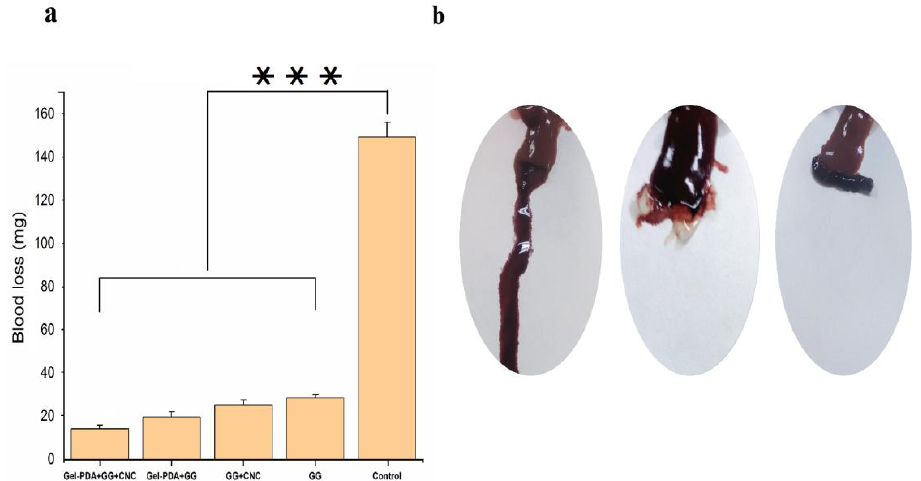
Figure 6. Hemostasis activity of hydrogels. ( a ) Blood loss from rat livers with and without hydrogels (*** p < 0.001), ( b ) macroscopic analysis of hemostasis; left: control without hydrogel; middle: GG hydrogel applied on the bleeding site; right: Gel − PDA+GG+CNC hydrogel applied on the bleeding site.